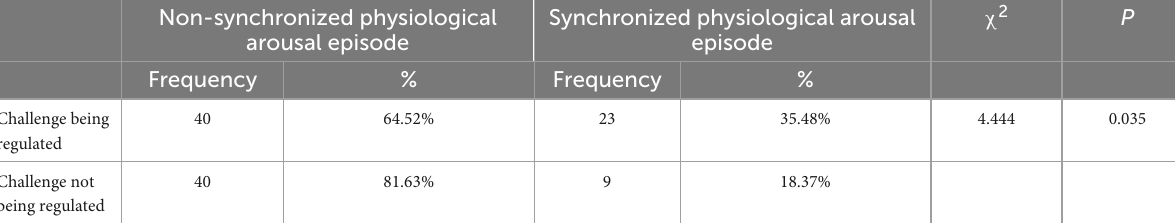
TABLE 8 Differences in synchronized physiological arousal episodes frequency between the challenge being regulated and the challenge not being